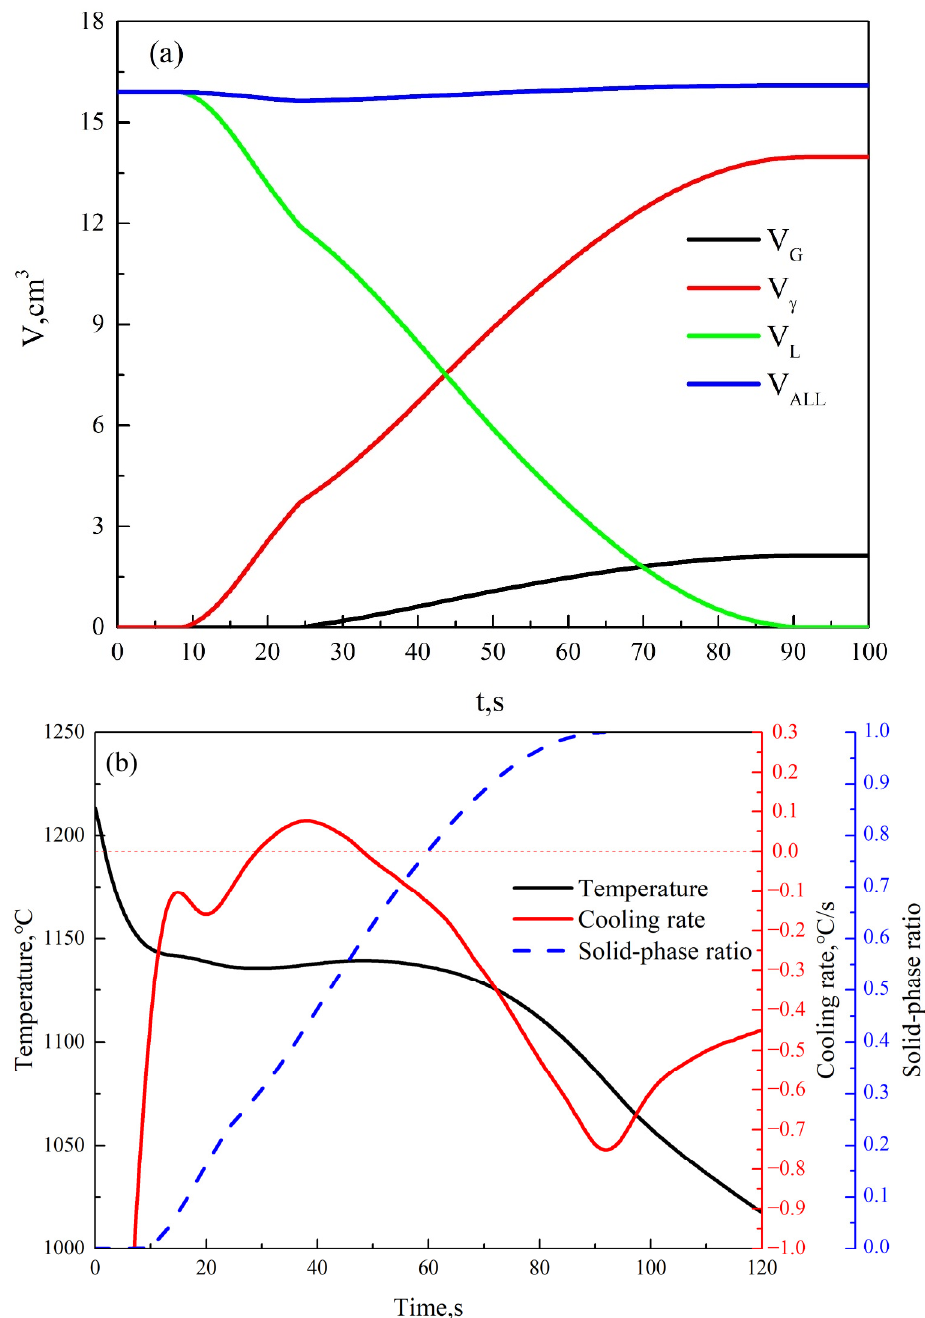
Figure 12. Changes of phase volume and solid-phase rate during solidification: ( a ) change of the phase volume and ( b ) change of the solid phase rate.